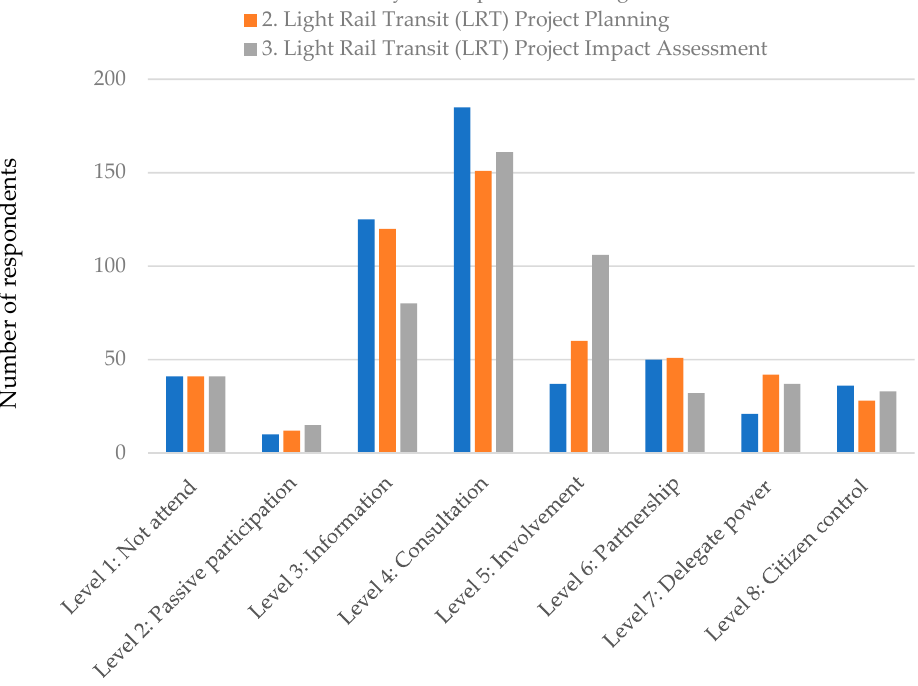
Figure 7. Citizen participation patterns in PP activities of the LRT project (n = 505).